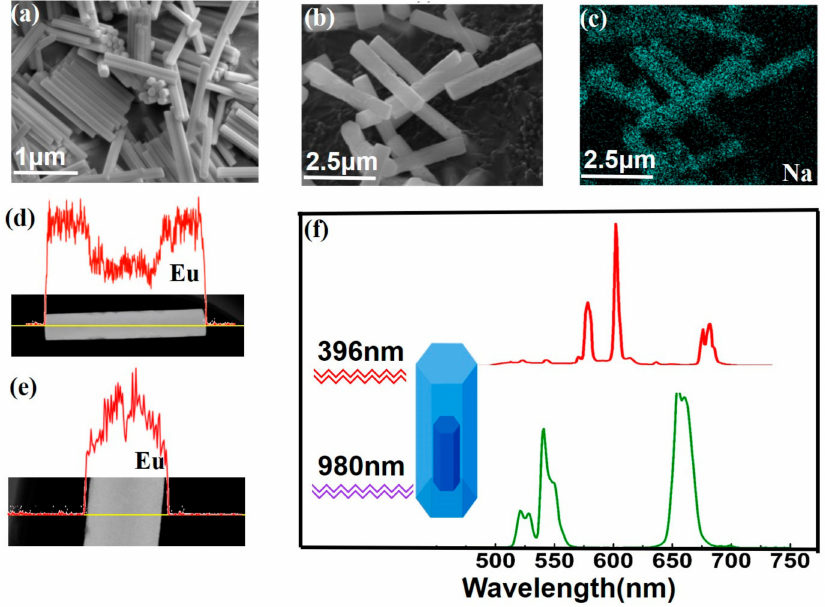
Figure 5. ( a , b ) SEM images of the microcrystals, NaYF 4 :Yb/Er (5/0.05 mol %) and NaYF 4 :Yb/Er (5/0.05 mol %)@NaYF 4 :Eu (10 mol %); ( c ) element mappings of Na in the microcrystals; ( d , e ) line